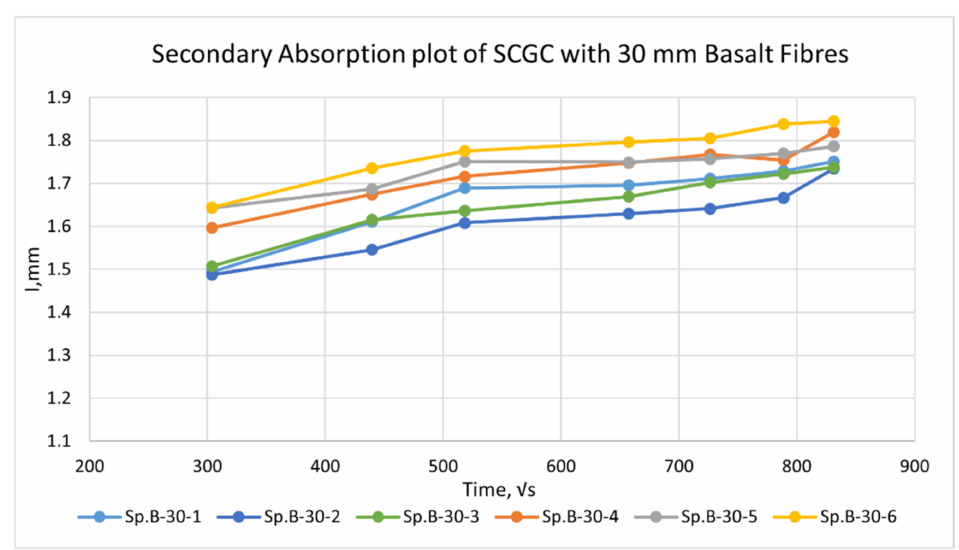
Figure 11. Secondary absorption plot of SCGC with 30 mm basalt